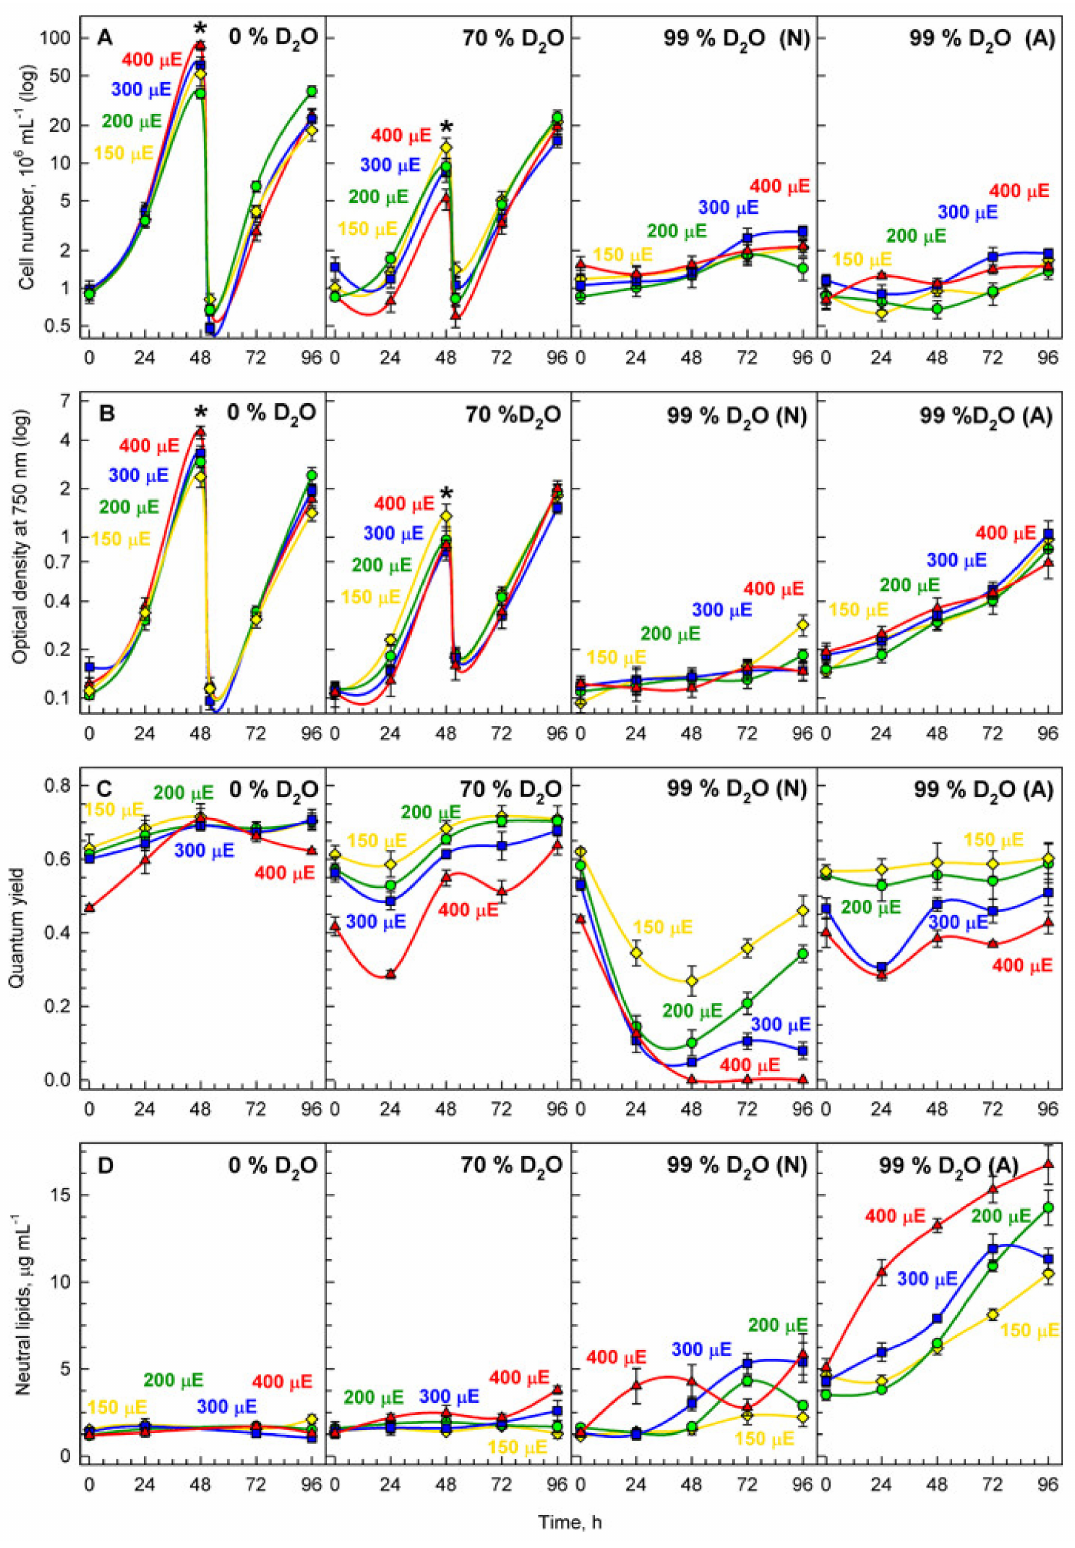
Figure 8. Time course of cell division and growth in synchronized cultures of Parachlorella kessleri grown at the optimal temperature of 30 ◦ C, different incident light intensities (400 (red triangles), 300 (blue squares), 200 (green circles), and 150 (yellow diamonds) µ mol photons m − 2 s − 1 ) and different concentrations of deuterated water in the medium (0, 70 and 99%). The cultures transferred directly from control conditions into 99% deuterated water are denoted as “N”, the cultures pre-adapted at the same concentration for one week are denoted as “A”. Panel ( A ): cell number (10 6 mL − 1 ), Panel ( B ): Optical density at 750 nm, Panel ( C ): quantum yield, Panel ( D ): neutral lipids ( µ g mL − 1 ). Note the logarithmic scale on Y axis for A and